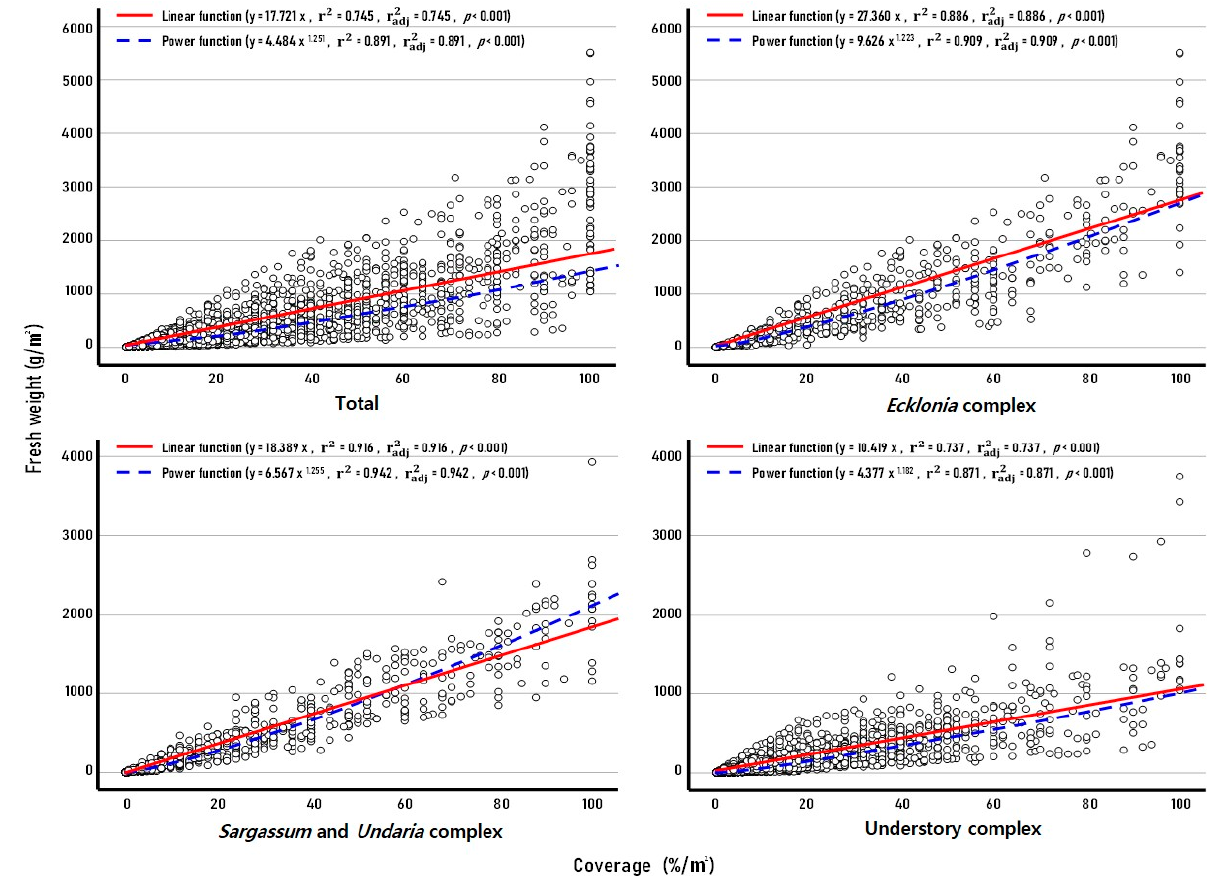
Figure 2. Regression analysis shown in data set from the marine macro algal group.